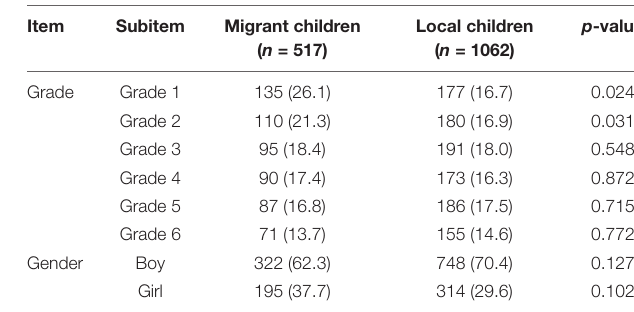
TABLE 3 | Comparison on distribution of migrant